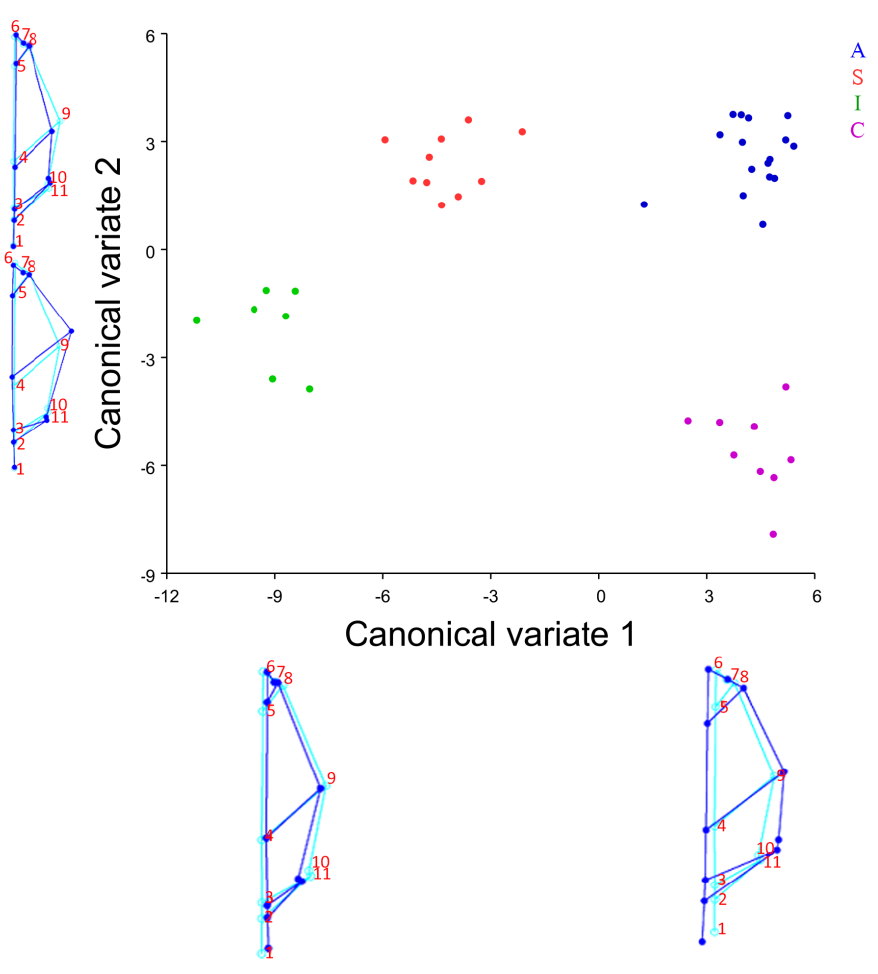
Figure 3. Canonical analysis of the four species in the Akfadou forest [Q. afares (A), Q. suber (S), Q. ilex (I), Q. canariensis (C)], and representation of leaf differences along the two canonical axes (CV1 = 66.93%, CV2 =